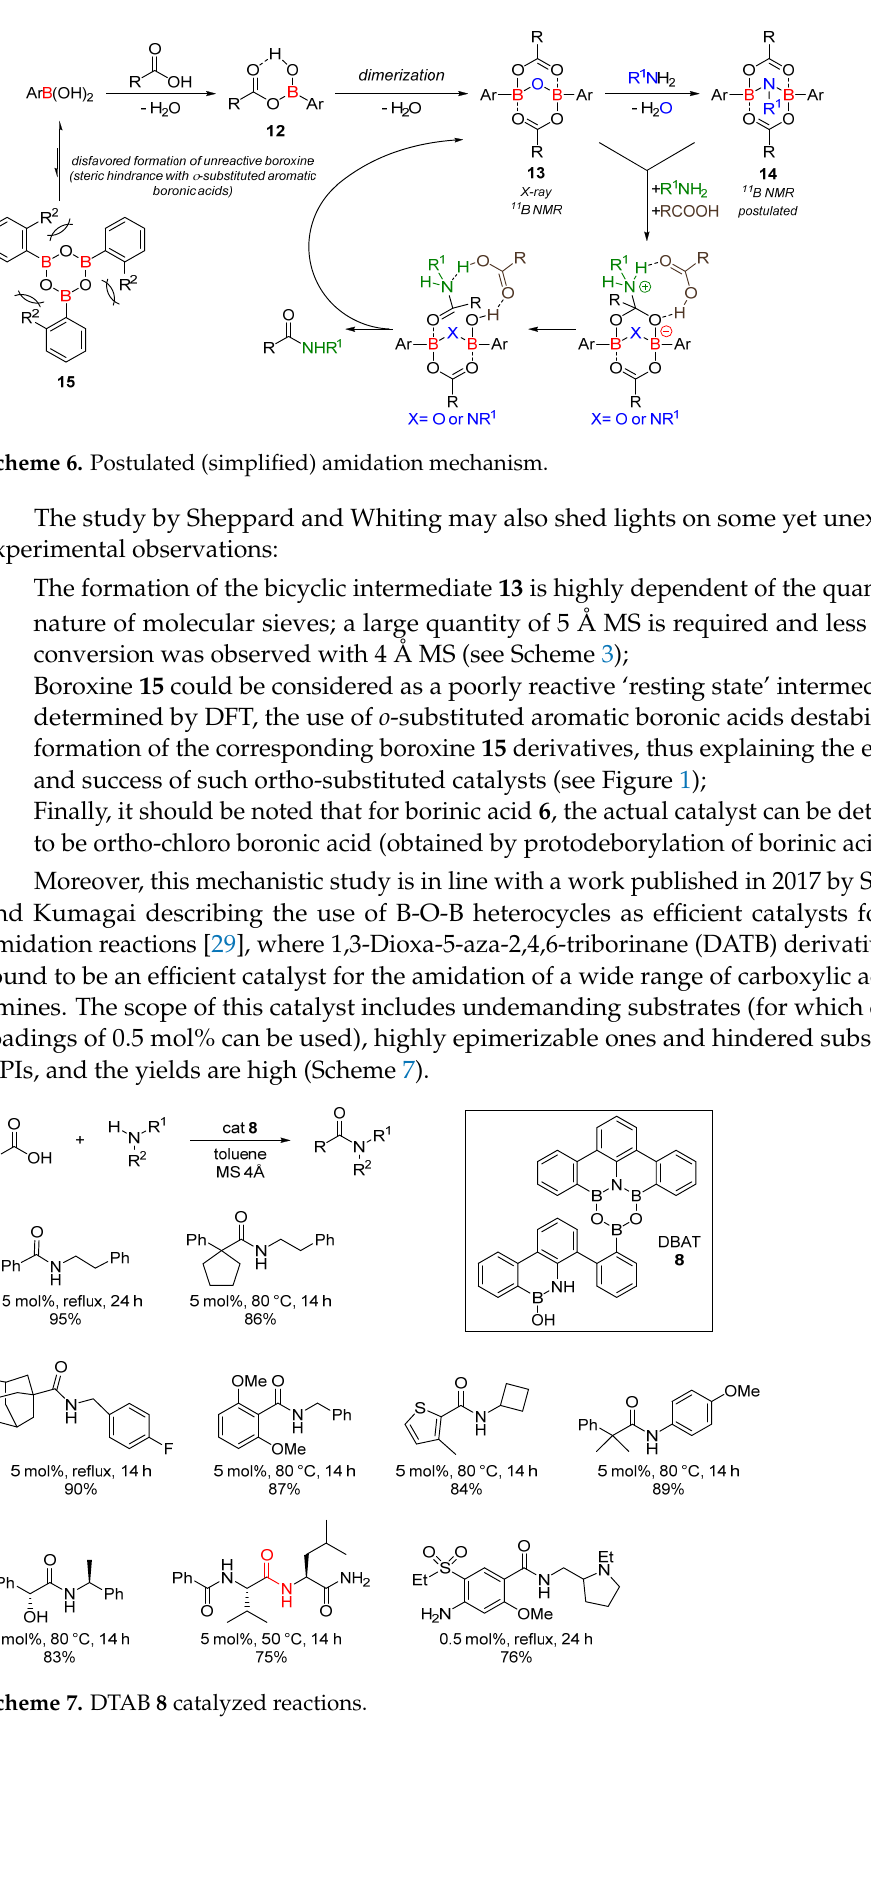
Figure 2. Pym ‐ DTAB structure. Mechanistic studies have highlighted the dual role of the two distinct classes of boron atoms [32]. The most Lewis acidic “O ‐ B ‐ O” boron atoms readily activate the amine via an adduct formation. The “B ‐ N ‐ B” moiety reacts as both a Br ø nsted base and a Lewis acid, allowing the formation of a “B ‐ O=C ‐ O ‐ B” cyclic complex where the electrophilicity of the carboxylic function is activated (Scheme 8). Scheme 8. Intermediates involved in the DTAB ‐ catalyzed reactions. Saito also described the use of simpler diboron structures—tetrahydroxy diboron and tetrakis(dimethylamino) diboron 9 —to enable the catalytic amidation of various (het ‐ ero)aromatic acids in refluxing toluene, with good yields with low catalytic loadings (2